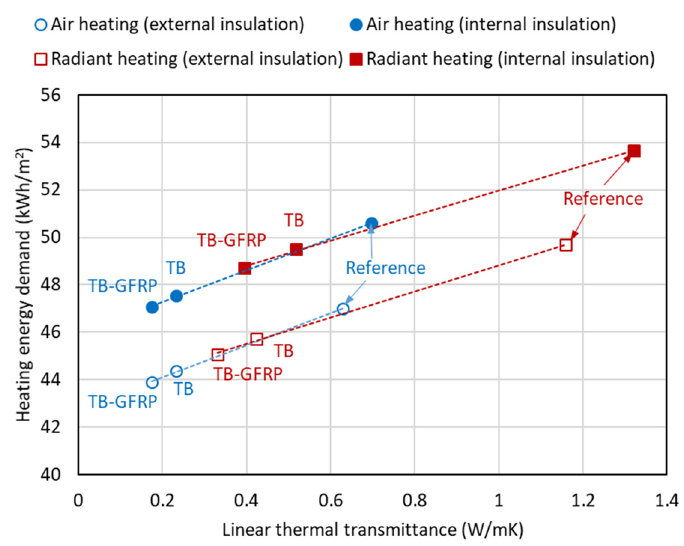
Figure 11. Linear thermal transmittance with heating energy demand.